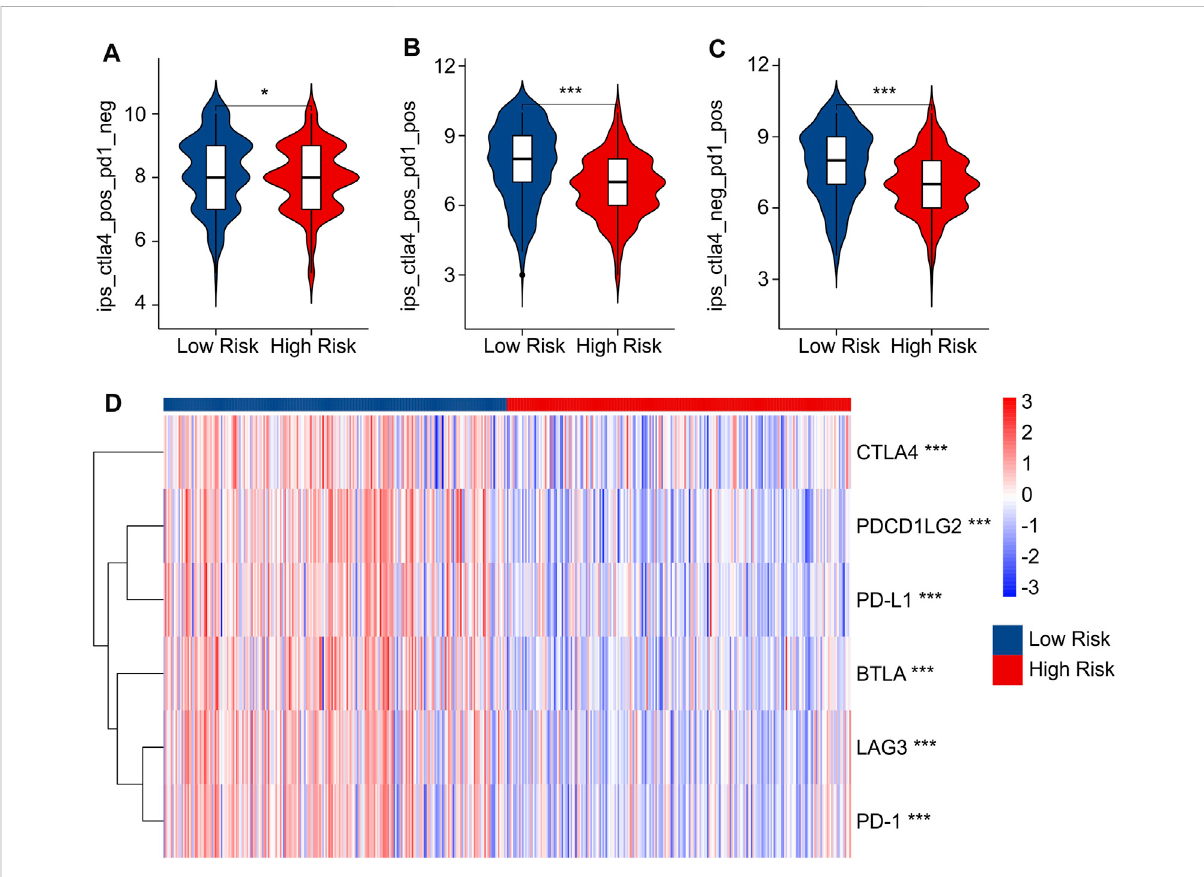
FIGURE 8 IPS scores and immune checkpoint expression of low- and high-risk groups. (A – C) IPS score showed the response of ICI in low- and high-risk groups. (D) Immune checkpoints expression in low- and high-risk